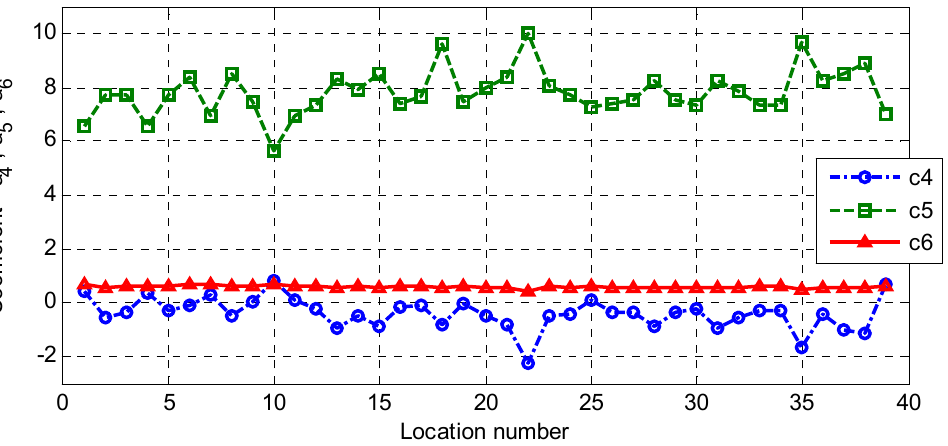
Figure 14. Model parameters c4 – c6 for description of the joint distribution of u w and Hs per location.